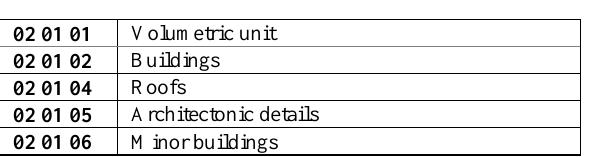
Table 3. The admissible values for the third level of the ‘0201’ branch